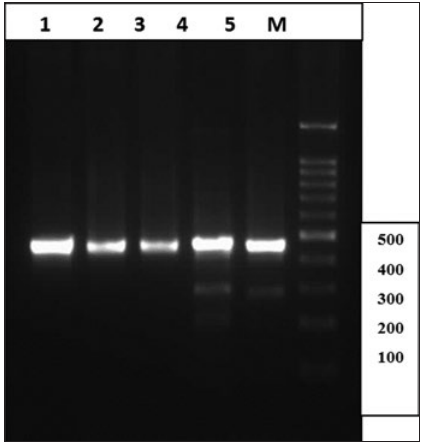
Figure-2: Electrophoresis of polymerase chain reaction products of the cox1 gene of E. granulosus using DNA extracted by different methods. Lane 1: Samples extracted by the commercial kit in two-step incubation procedure (initially at 60°C for 2 h and then overnight at 37°C); Lane 2: Samples extracted by the commercial kit in one step at 60°C for 2 h; Lane 3: Samples extracted by the commercial kit in one step at 37°C with overnight incubation; Lane 4: Samples extracted manually, using phenol/chloroform and freeze/thawing; and Lane 5: Samples extracted by Triton X-100; M: Molecular weight